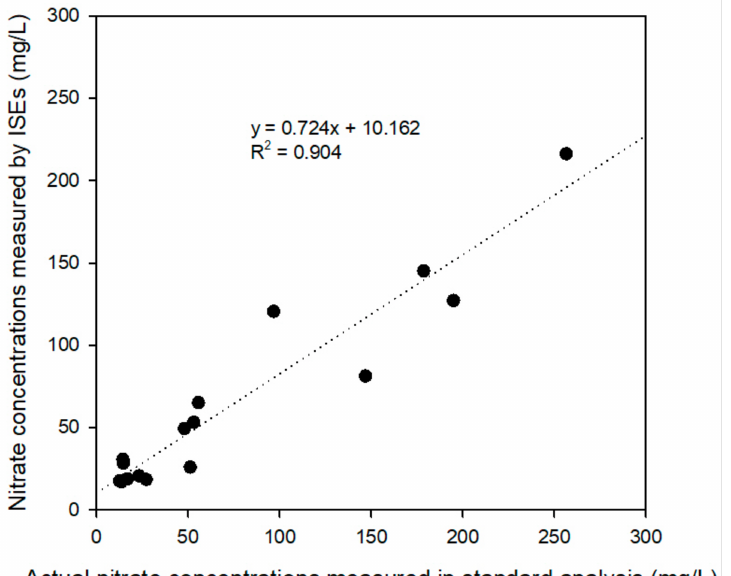
Figure 11. Linear relationship between ion concentration determined by ISEs and standard